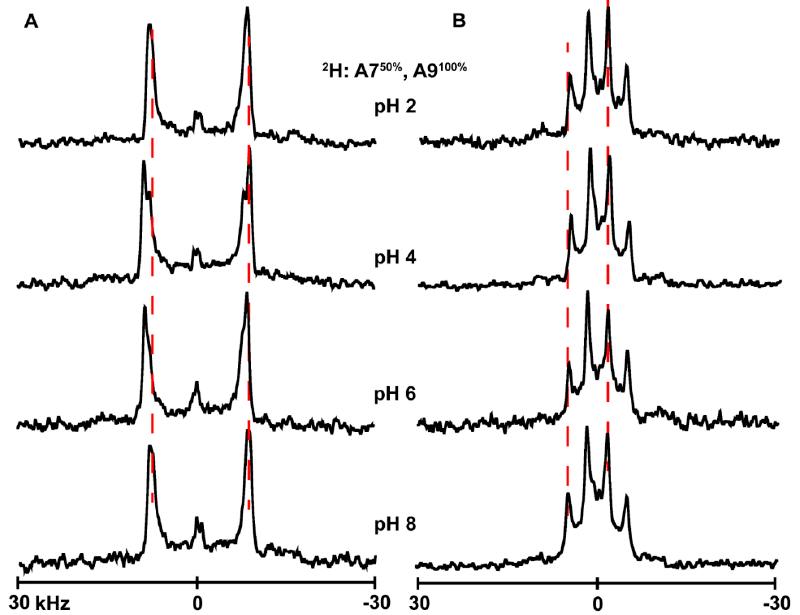
Figure 7. Selected 2 H NMR spectra to show the pH dependence of resonances for labeled A7 and A9 of H 2 GWALP23 in DLPC ( A ) and DOPC ( B ) lipid bilayers. Temperature 50 ◦ C; β = 90 ◦ sample orientation.